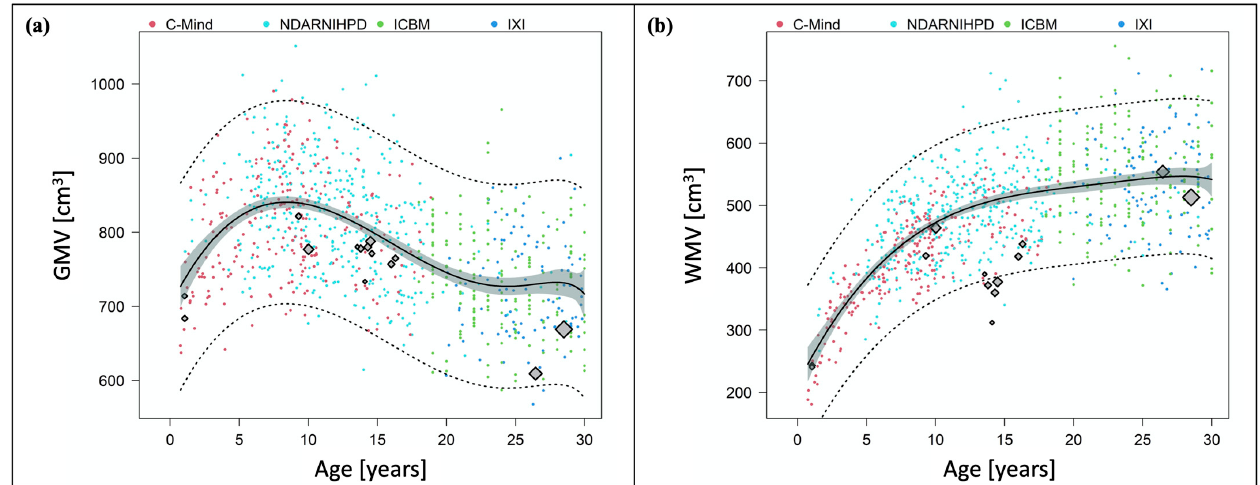
Figure 2. Mean absolute grey and white matter volumes after preterm birth compared to full-term controls. The four different datasets on FT controls are illustrated in different colors. C-MIND is presented in red, NDAR-NIHPD in in cyan, ICBM in green, and IXI in blue. Mean absolute volumes from the PT studies are included as diamonds. The size of each diamond is proportional to the sample size of the study. ( a ) Mean absolute GMV after PT birth compared to FT controls. The graph shows mean absolute GMV extracted from the PT studies contrasted against the GMV trajectory of FT controls with 95%-CI (grey areas) and 95%-PI (dotted lines). ( b ) Mean absolute WMV after PT birth compared to FT controls. The graph shows mean absolute WMV extracted from the PT studies contrasted against the WMV trajectory of FT controls with 95%-CI (grey areas) and 95%-PI (dotted lines).